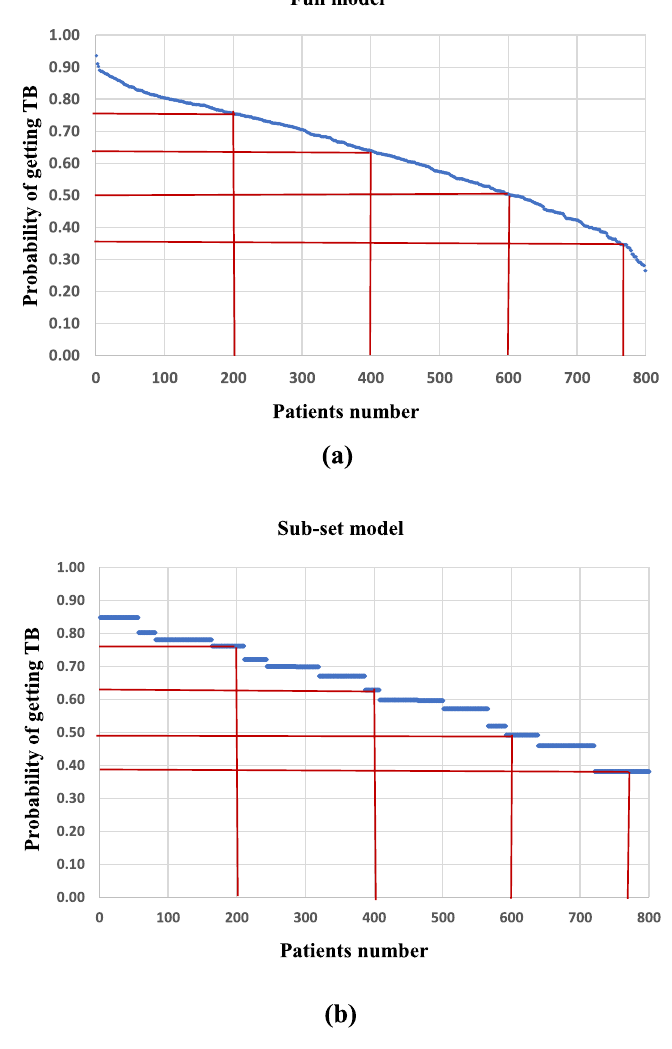
Figure 2. Probability plot for ( a ) full model, and ( b ) sub-set model (Eq.